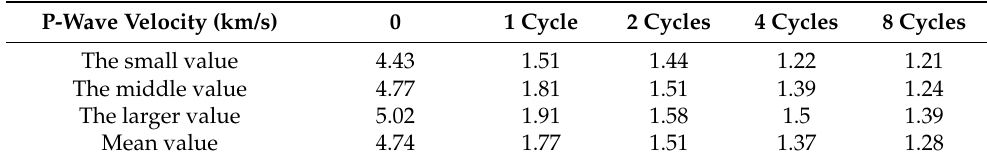
Table 2. Variation in V p of marble with the number of thermal cycles. P-Wave Velocity